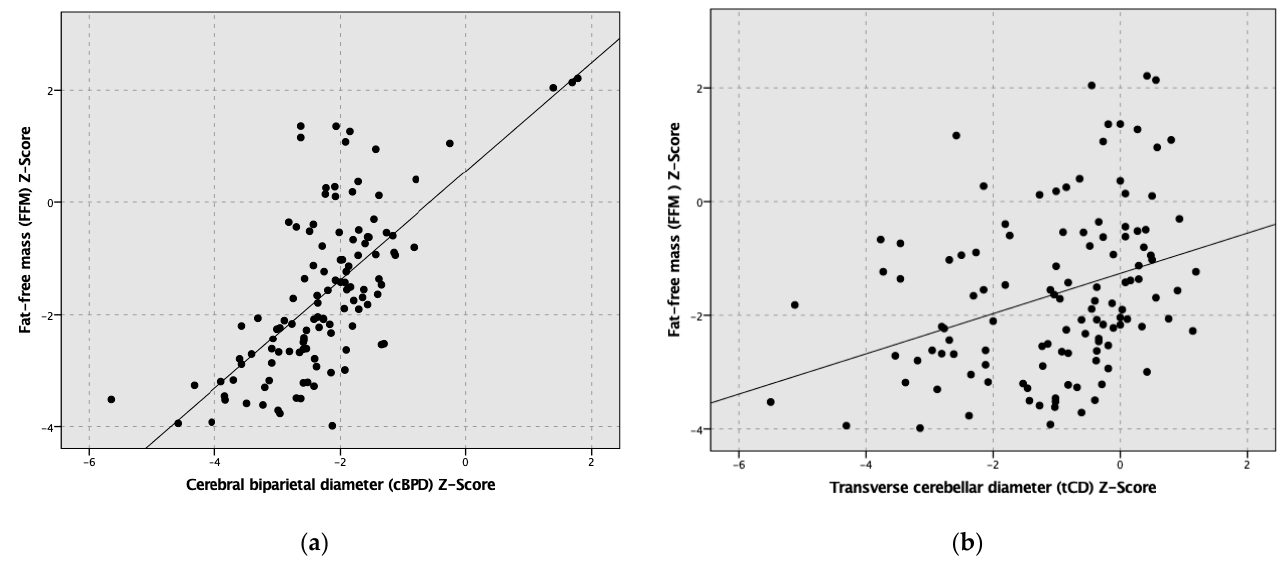
Figure 2. Scatterplots of fat-free mass Z-Score and ( a ) cerebral biparietal diameter Z-Score; ( b ) transverse cerebellar diameter Z-Score at term-equivalent age ( n = 118).